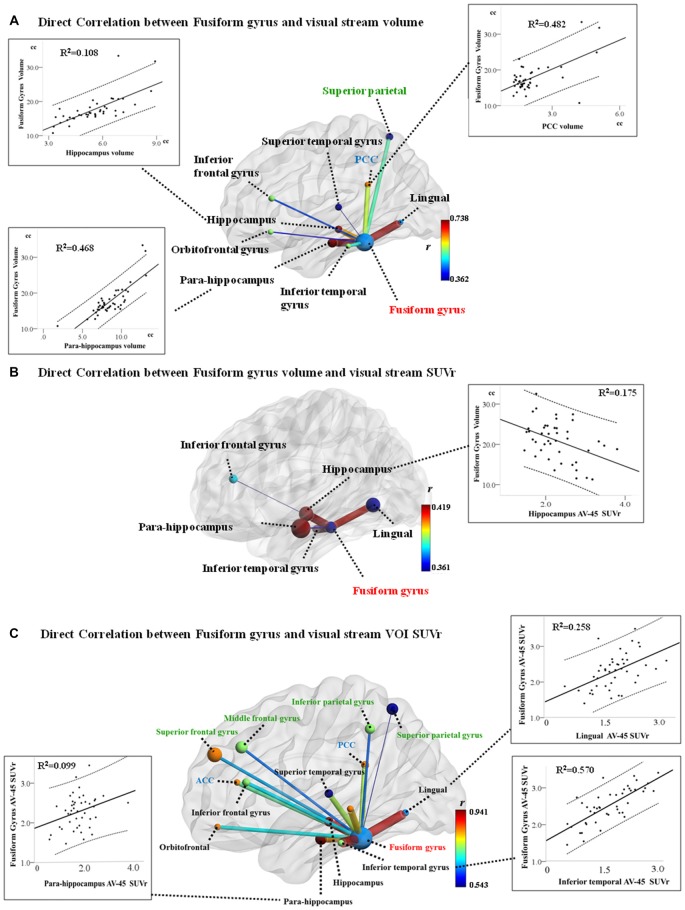
Structural co-variance (A), volume-amyloid burden (B) and amyloid burden co-variance (C) between the fusiform gyrus (FG) and visual network hubs. Model of the FG volume and structural covariant regional volume, and scatter plot of the age, sex, and total intracranial volume (TIV)-adjusted FG volumes with volumes of the hippocampus, para-hippocampus, and the posterior cingulate cortex (PCC). Superior parietal volume inversely correlates with FG volume exclusively. (B) Model of inverse correlation between FG volume and regional AV-45 standardized uptake value (SUV) ratio (SUVr), and scatter plot of the age, sex, and TIV-adjusted FG volume with SUVr in the hippocampus. (C) Model of positive correlation between the regions within visual stream and FG AV-45 SUVr, and scatter plot of the age and sex-adjusted FG SUVr with SUVr in the inferior temporal, lingual gyrus, and para-hippocampus. (Dotted lines represent 95% confidence limits for linear regression; regions with black text belong to the ventral visual stream; regions with green text belong to the dorsal visual stream).